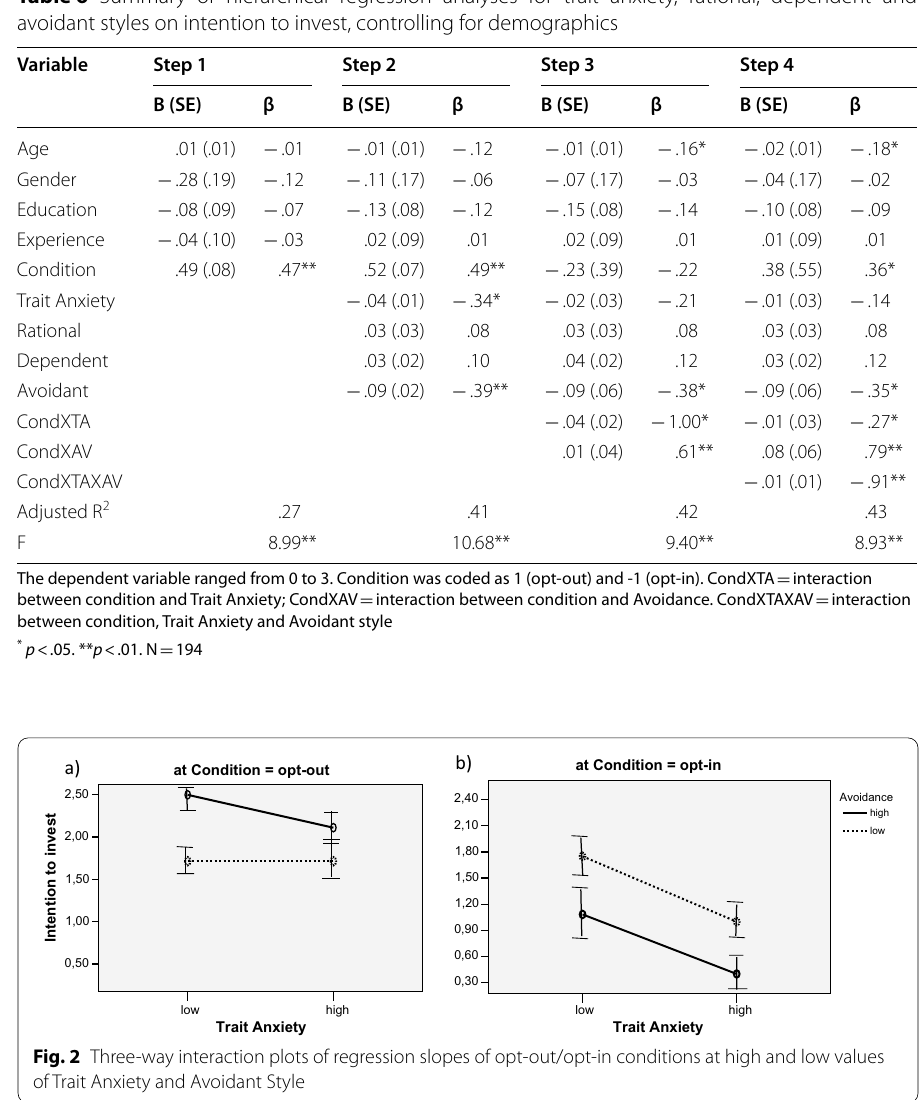
Fig. 2 Three-way interaction plots of regression slopes of opt-out/opt-in conditions at high and low values of Trait Anxiety and Avoidant